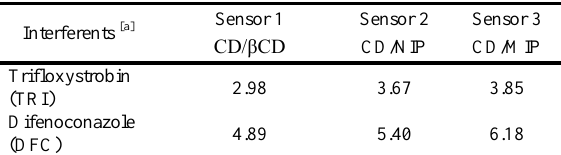
[a] Average of three